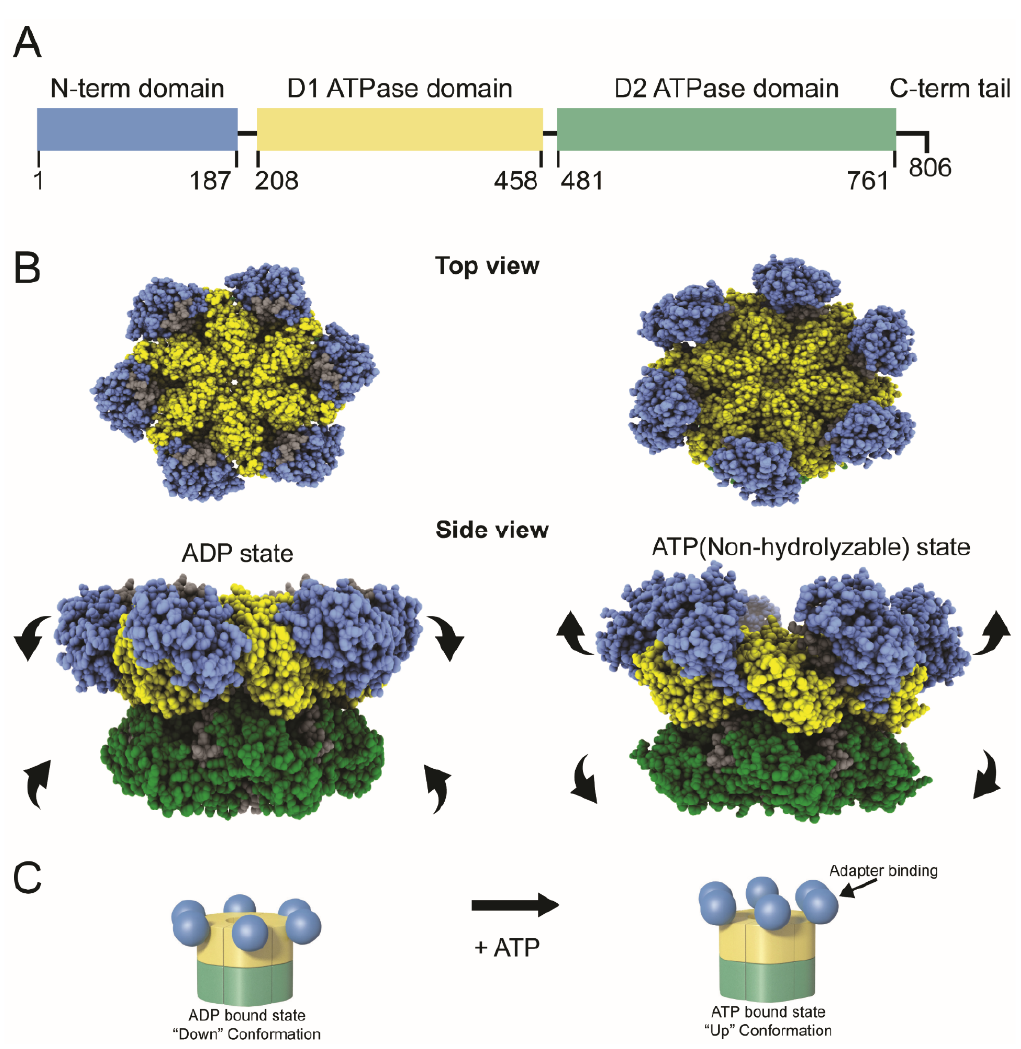
Figure 1. Domain structure and conformational changes in the VCP/p97 ATPase. ( A ) Diagram of the domains within the VCP/p97 monomer. Amino acid positions of each domain are indicated. ( B ) Cryoelectron microscopic images of VCP hexamers in the presence of ADP and ATP (non-hydrolyzable analog). The top view shows the propeller-like appearance of the six monomer subunits surrounding a central channel. The side view depicts the conformational changes of each monomer in the presence of ADP or ATP γ S. The N-terminus and D1 and D2 domains are depicted in blue, yellow, and green respectively; other regions are shown in gray (PDB:5ftl and PDB:5ftn). [3]. In living cells, the unfolding ability of VCP is likely to be dependent on the sequential conformational changes in adjacent monomers to pull the substrate through the central pore ( C ) Cartoon depiction of the conformational switch in the N-terminal domains within the p97 hexamer. Color coding of the domains corresponds to panel A. In the ADP-bound state, the N-terminal domains primarily are in the “down” conformation. In the ATP-bound state, the N-terminal domains are in the “up” conformation for interactions with other proteins, often with adapters that recognize polyubiquitylated proteins. It is likely that many VCP hexamers have a mixture of “up” and “down” conformations within monomers, which allows the hand-over-hand unfolding and extraction mechanism.